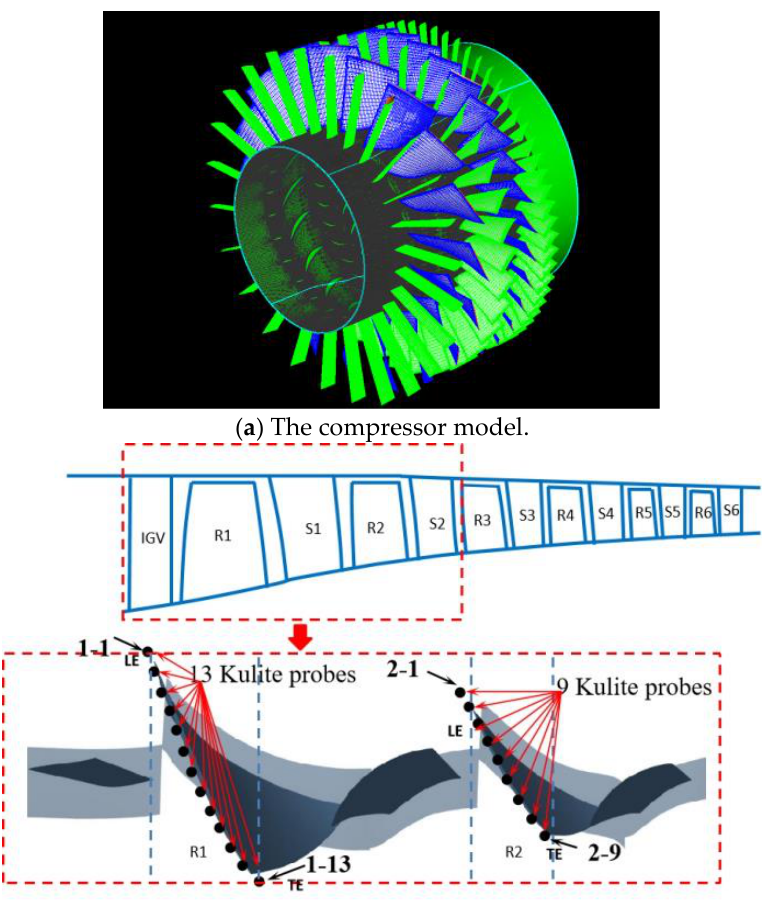
Figure 2. Setup of experiment.